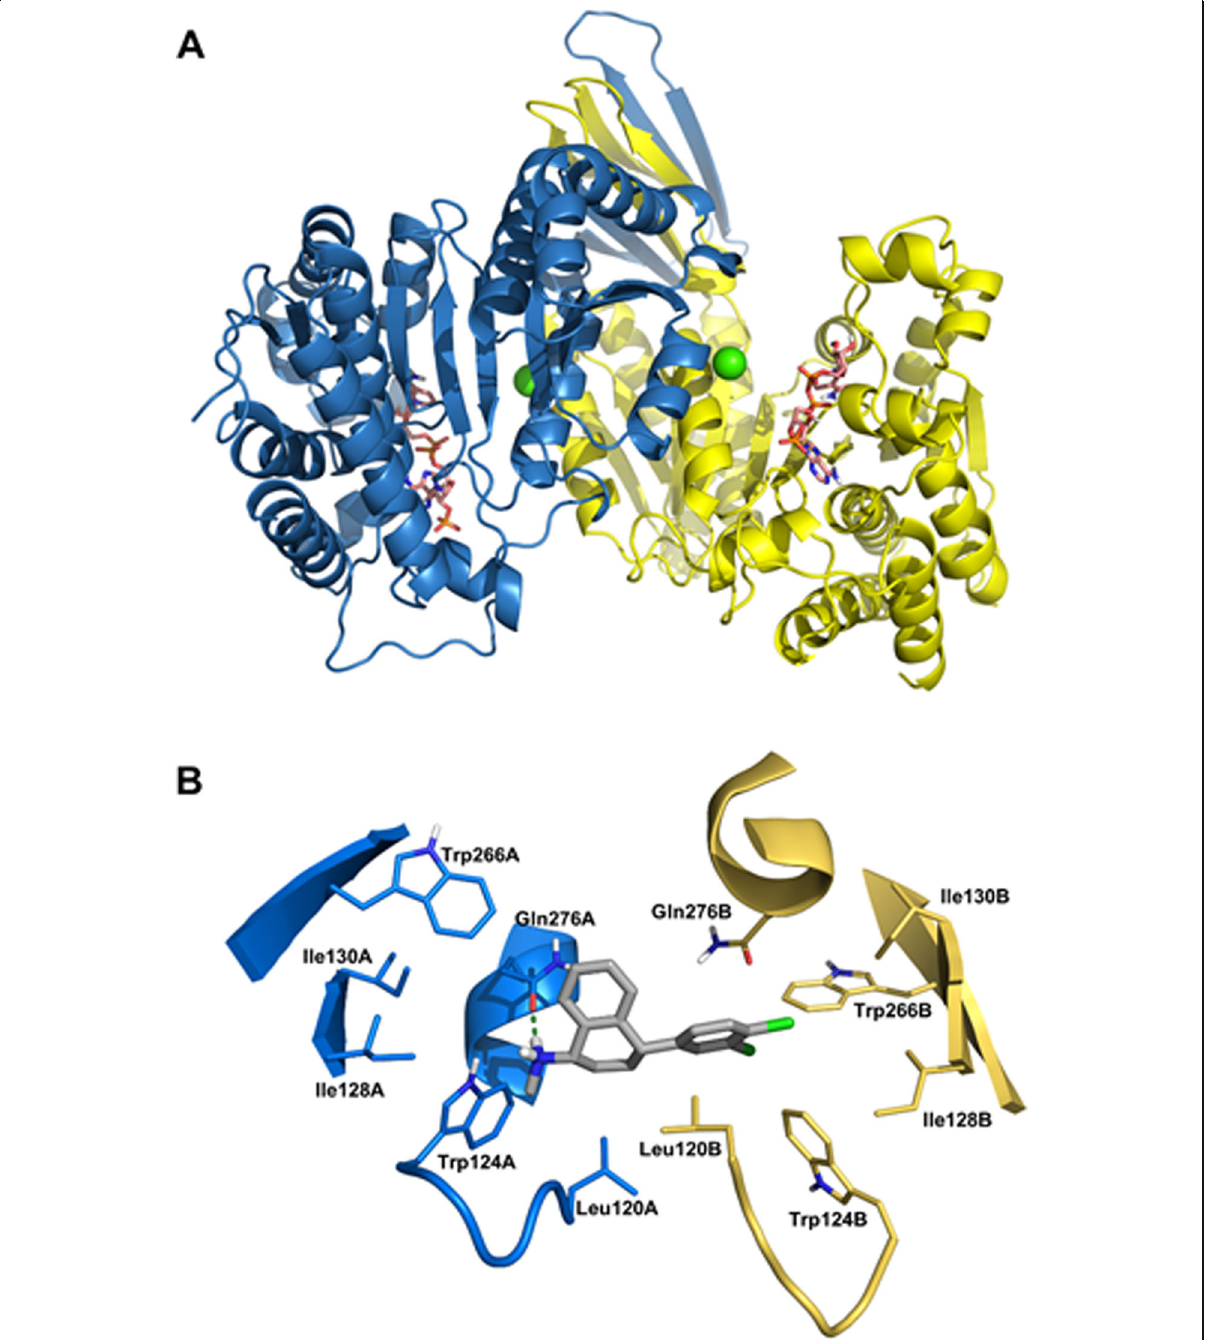
Fig. 3 3D structure of Tc IDH2 homology model. a Regions in blue represent Chain A and regions in yellow represent Chain B. The Ca 2+ ions are indicated by green spheres. The two ligands presented in the stick model represent the co-factor NADP. b Interactions of sertraline with the allosteric binding site of Tc IDH2 were predicted by docking. The residues of chain A are in blue and chain B is colored in yellow, indicating the interface that constitutes the allosteric binding site. In the center, sertraline carbon atoms are colored gray, nitrogen in blue, chlorine atoms are green and hydrogens are white. The hydrogen bond between sertraline and Gln276A is indicated by a green dashed